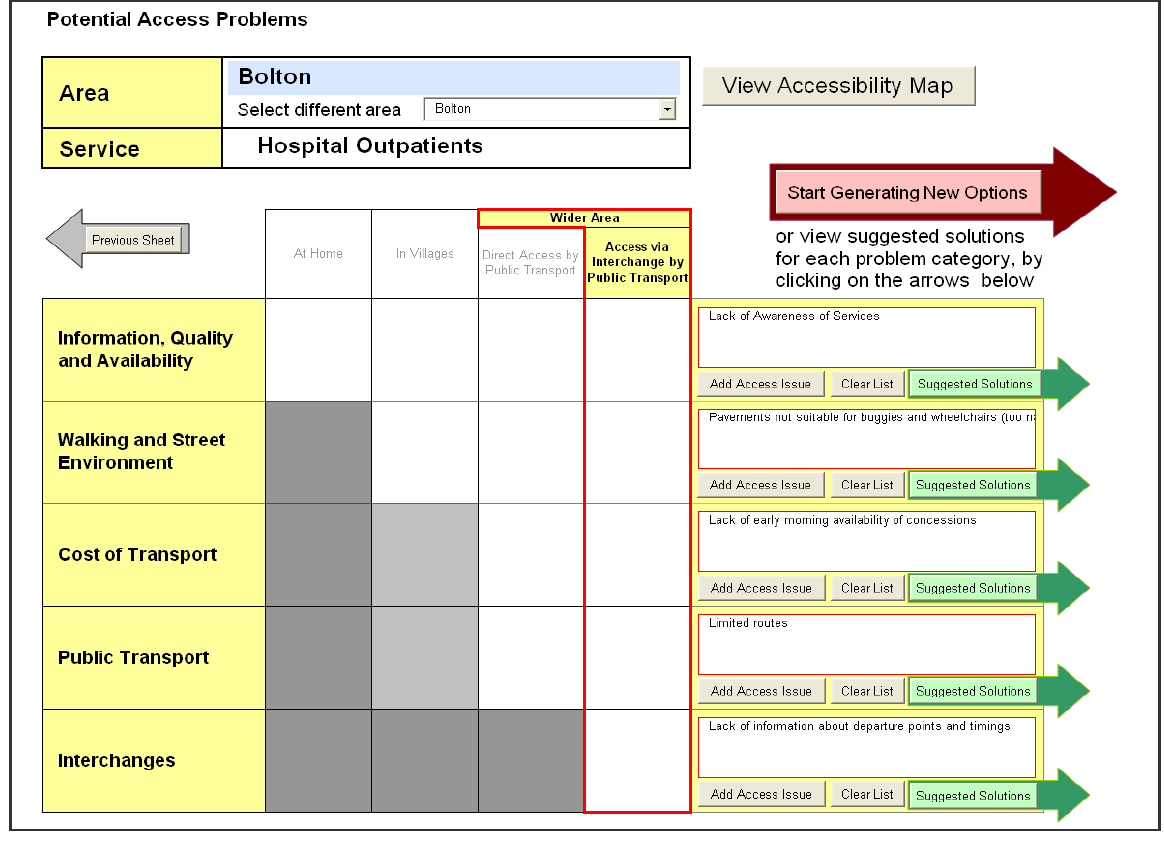
Figure 9. Access problems sheet Source: Jones and Paskins (2008), Figure 14